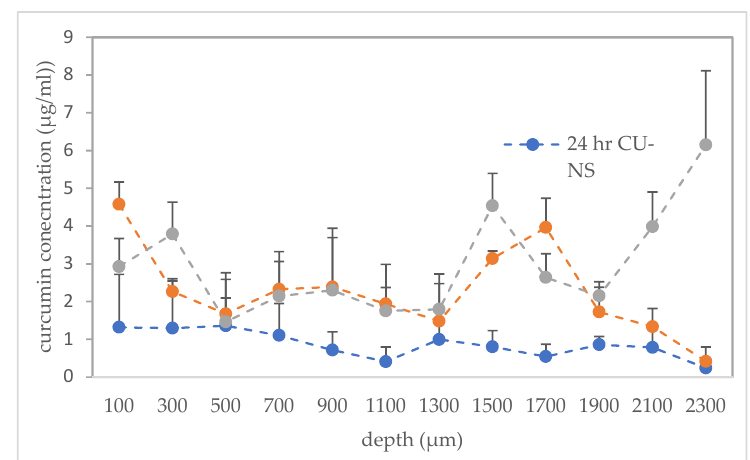
Figure 8. Concentrations of curcumin at different depths in ex vivo neonatal porcine skin for 24 h with CU-MN, for 2 h with CU-MN and for 24 h with the CU-NS alone. Means ± S.D., n = 3.